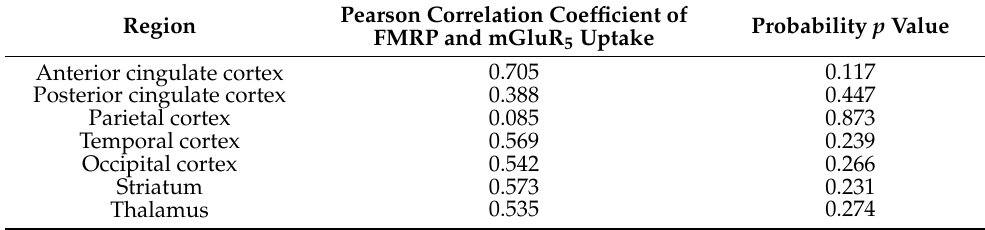
Table 3. Pearson correlation coefficient R between Fragile X Mental Retardation Protein (FMRP) in nanogram per microgram total protein and ratios of 3-[ 18 F]fluoro-5-(2-pyridinylethynyl)benzonitrile ([ 18 F]FPEB) uptake in the regions of interest (ROIs) to uptake in the cerebellum of men with the full mutation (FM) of fragile X syndrome [83]. Pearson Correlation Coefficient of Region Probability p Value FMRP and mGluR 5 Uptake Anterior cingulate